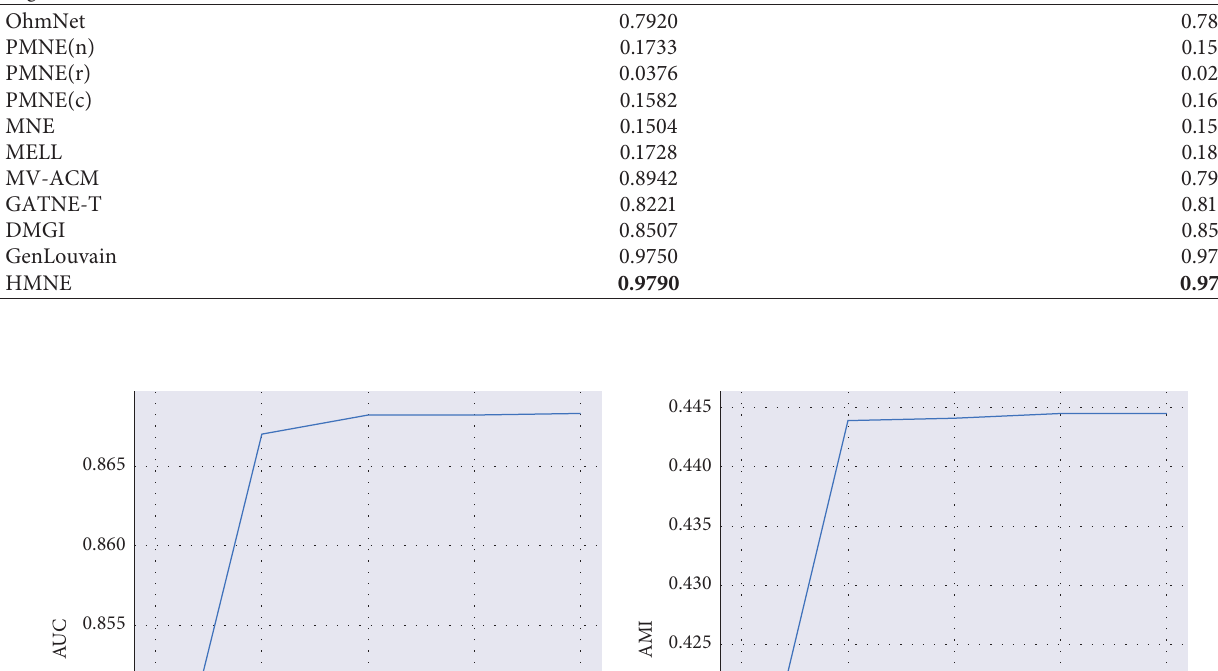
Table 4: The ARI and NMI scores’ performance of our HMNE and baseline methods on the CKM multiplex network dataset. Algorithm